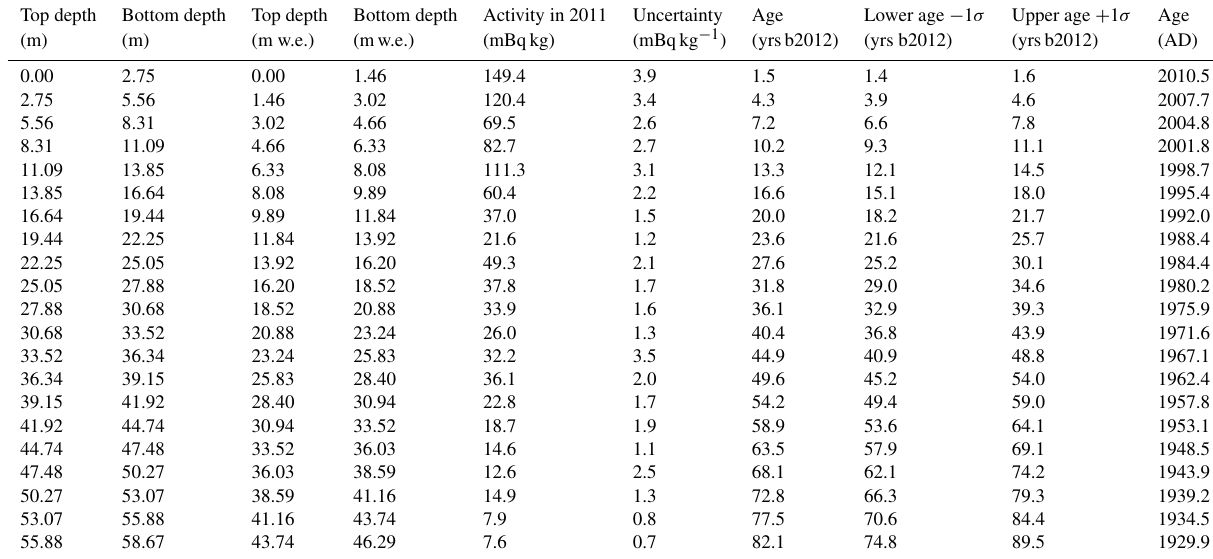
Table 1. 210 Pb dating. Determinations of 210 Pb activity and calculated ages for the upper part of the Mt. Ortles ice core no. 2 (0–58.67m). Note the notation used for ages in yrsb2012.